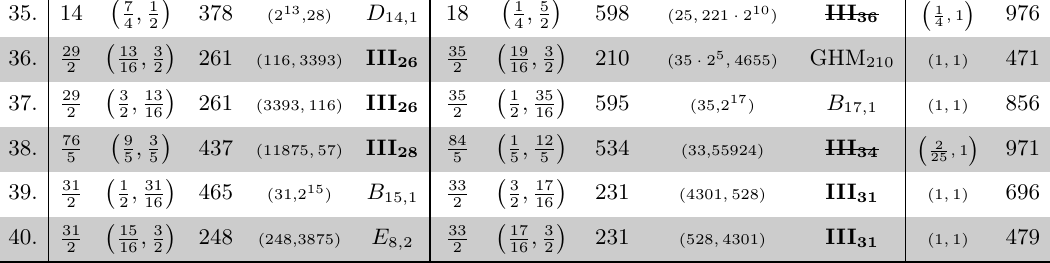
Table 16. Inconsistent pairings, c H = 32 with ( n 1 , n 2 ) = (2 , 3) The integer N in the last column gives the total number of dimension-1 states in the meromorphic character j 2